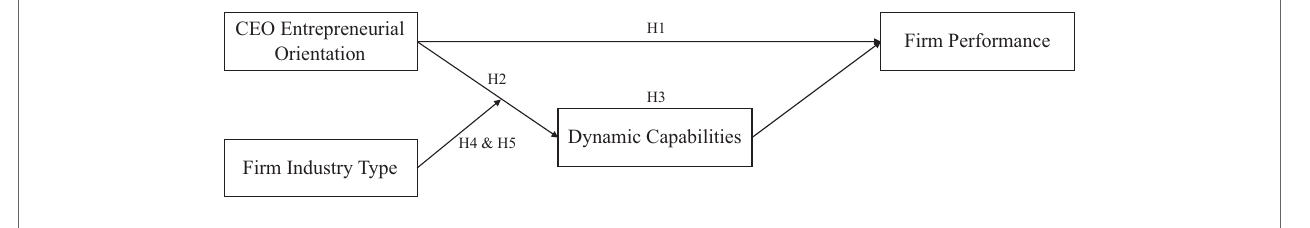
FIGURE 1 | The research framework of this